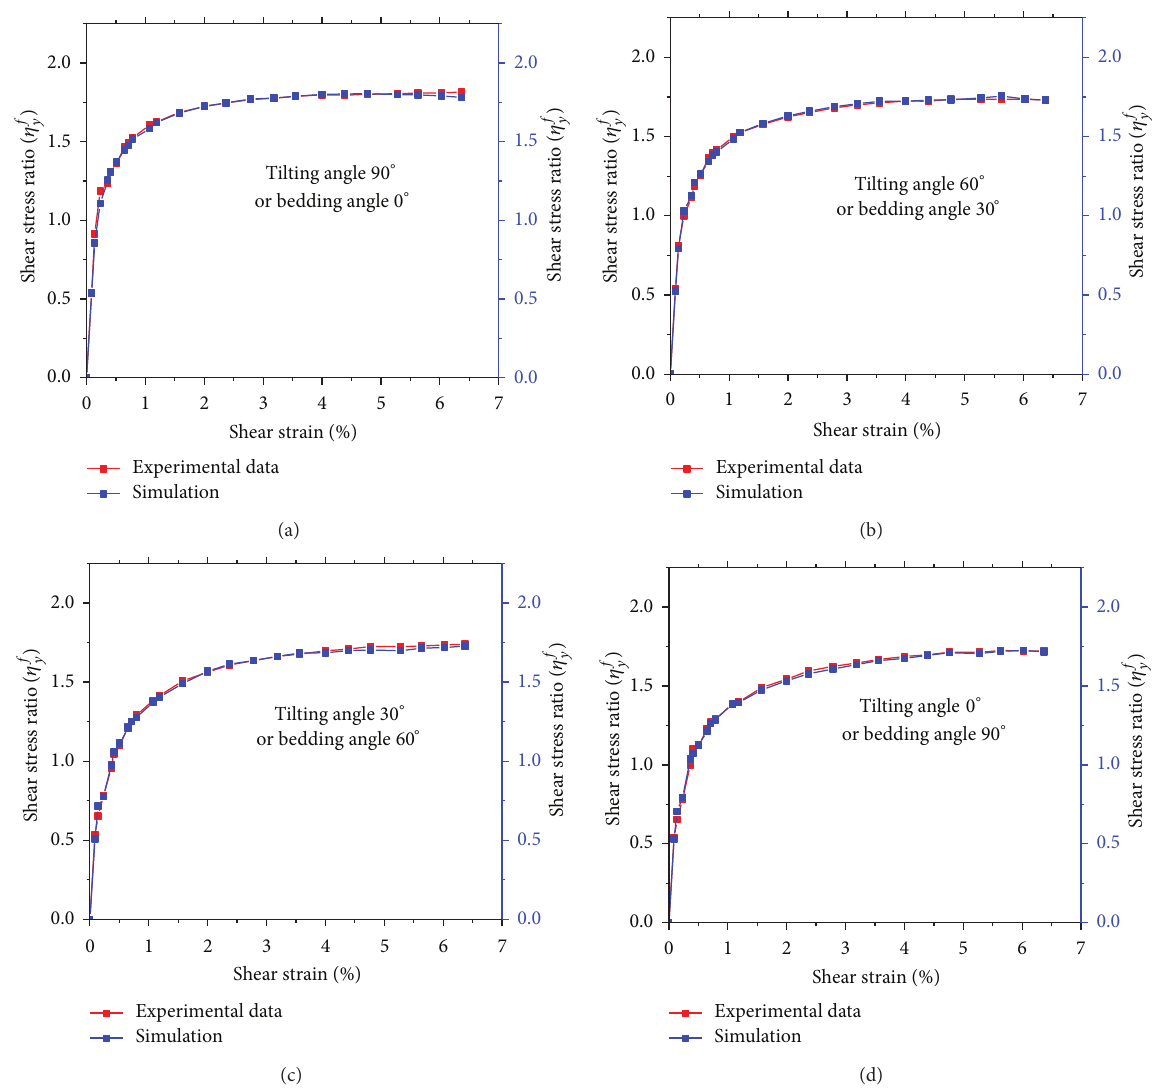
Figure 3: Comparison between experimental data and simulation by using (16) for the confining pressure 2.0kg/cm 2